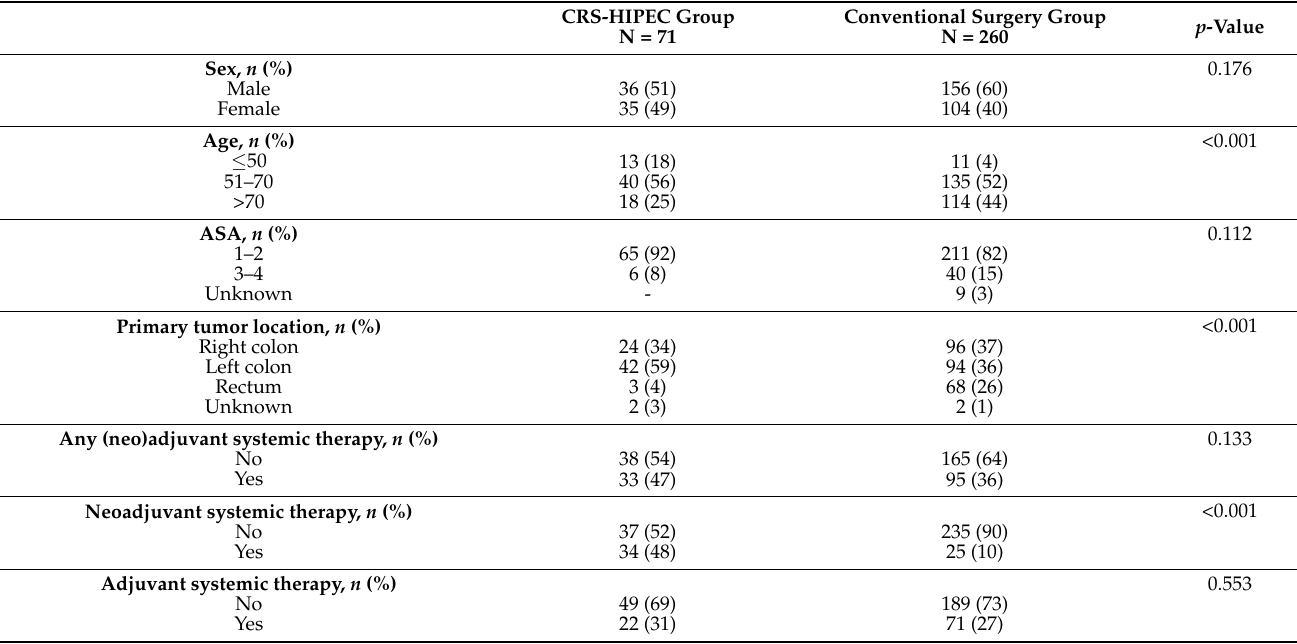
Table 1. Comparison of patient, tumor, and treatment characteristics between both